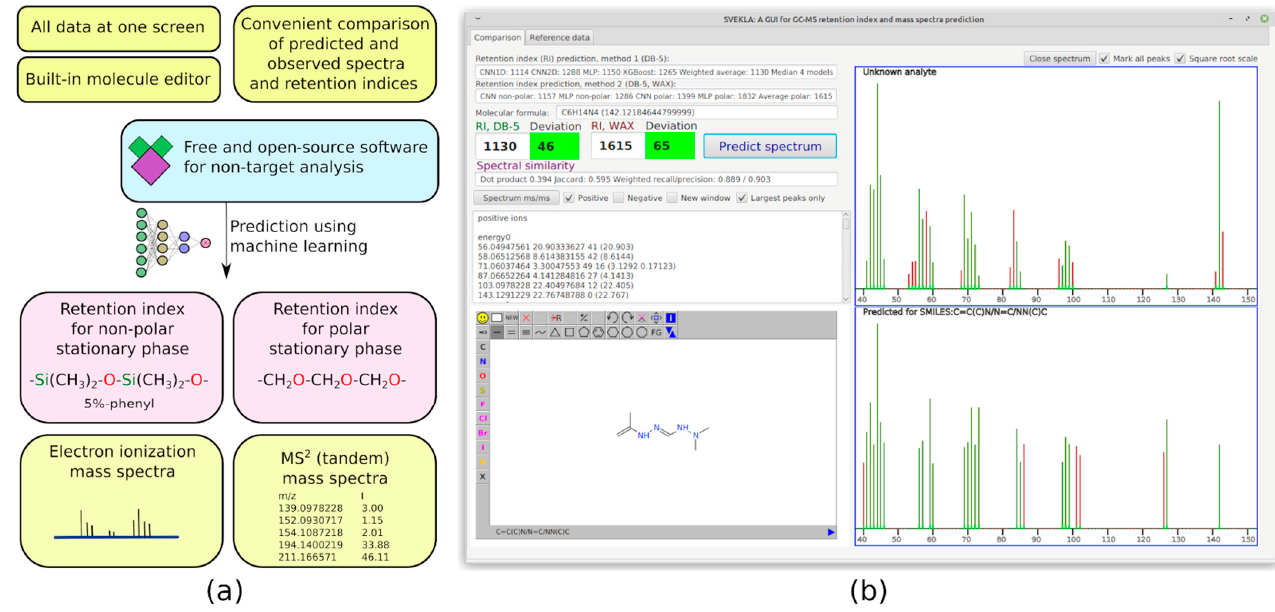
Figure 3. ( a ) Functionality of the developed software; ( b ) Sample screenshot of the